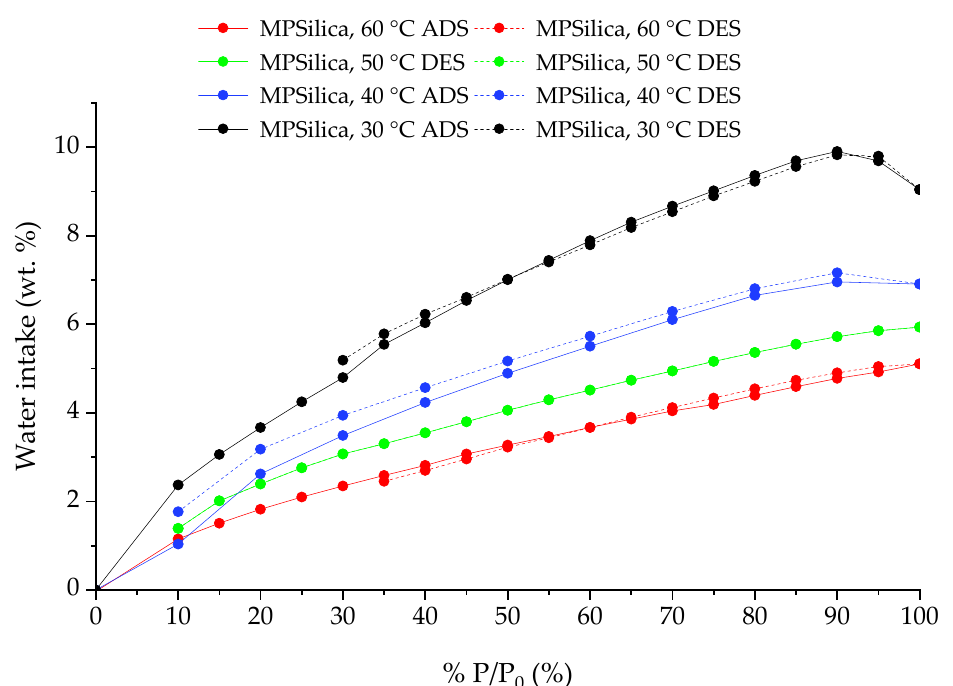
Figure 9. Adsorption and desorption isotherms for MPSilica samples, at 30, 40, 50 and 60 °C .